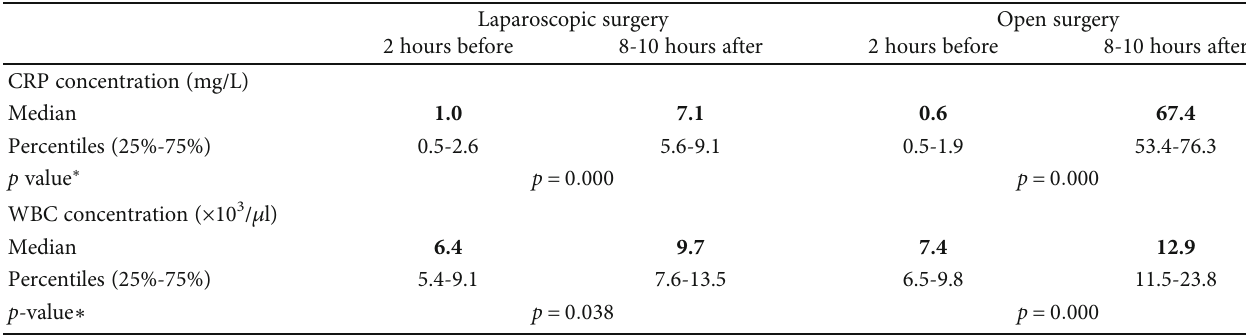
Table 4: The statistical parameters of serum C-reactive protein (CRP) and white blood cell count (WBC) values measured 2 hours before and 8-10 hours after laparoscopic and open